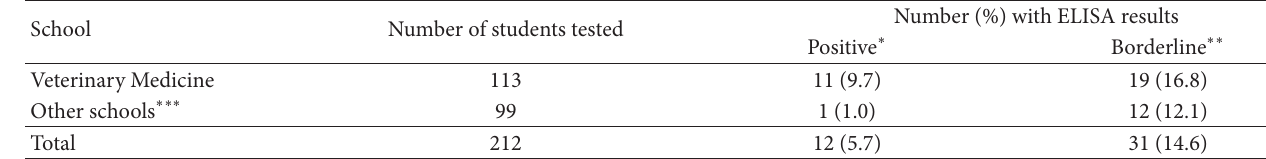
T 2: Frequency of detection of IgG immunoglobulins for leptospirosis by the